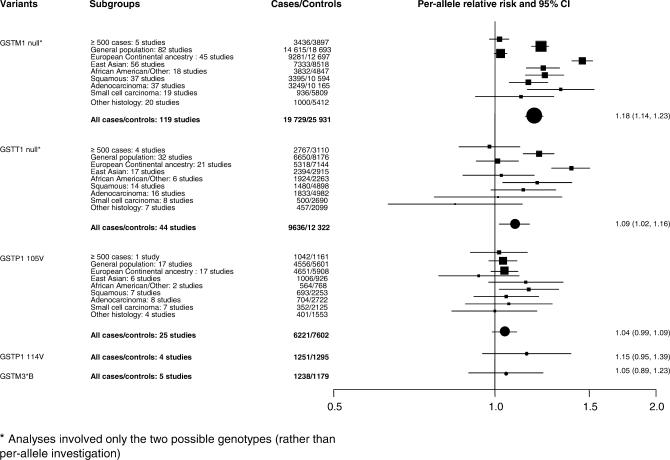
Meta-Analyses of Studies of Lung Cancer and Five
GST Gene Polymorphisms (
GSTM1 null,
GSTT1 null, and
GSTP1 I105V,
GSTP1 A114V, and
GSTM3 intron 6) Grouped by Various Characteristics